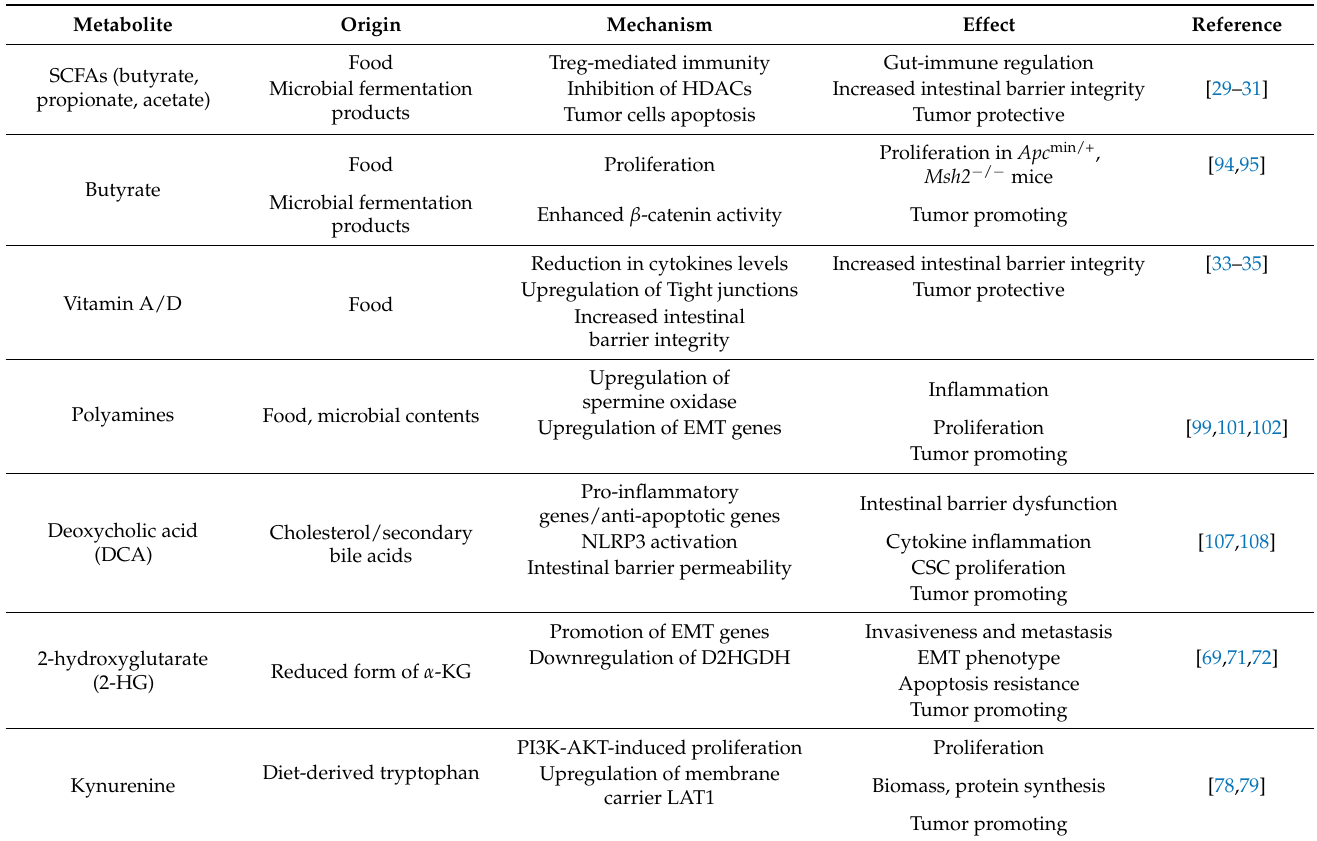
Table 1. Evidence of known food and microbial-derived metabolites in CRC: α -KG: alpha ketog- lutarate; CSC: cancer stem cells; D2HGDH: D-2-hydroxyglutarate dehydrogenase; EMT: epithelial- mesenchymal transition; HDAC: Histone deacetylase; LAT1: L-type amino acid transporter; NLRP3: NLR family pyrin domain containing 3; SCFAs: Short-chain fatty acids; Tregs: T regulatory